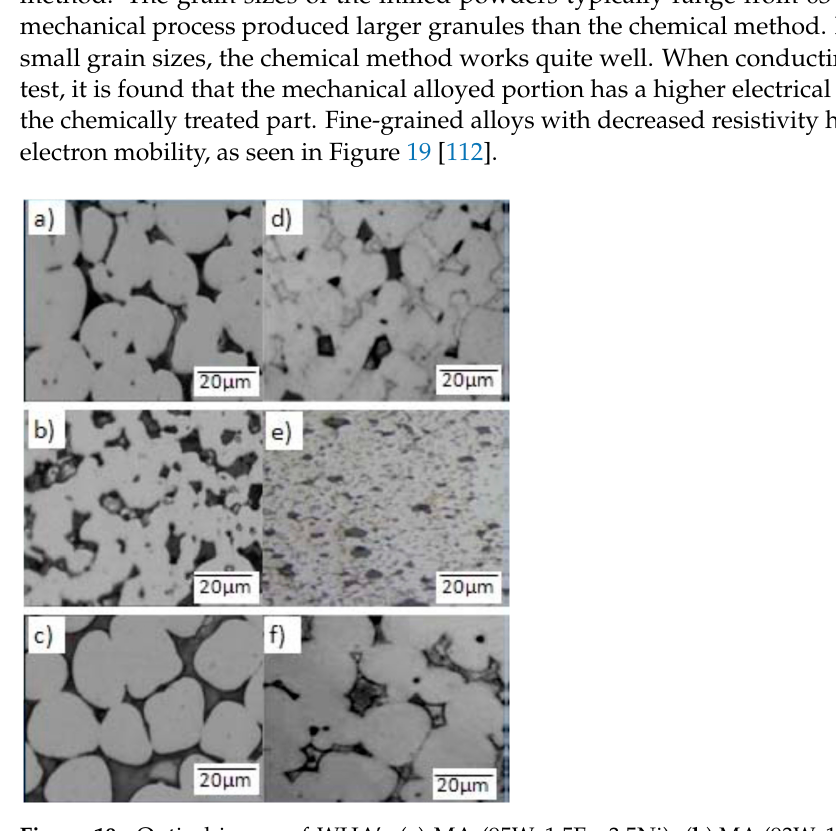
Figure 18. The heating mode impacts radial shrinkage [110].